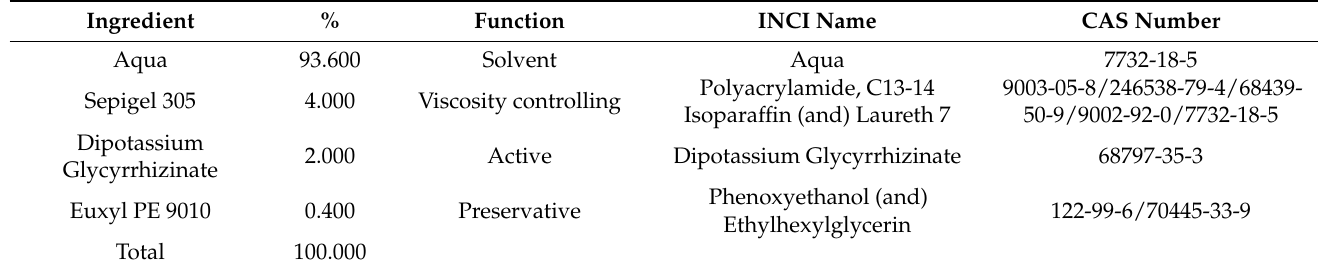
Table 1. Composition of the dipotassium glycyrrhizinate (DPG) formulation—2% gel